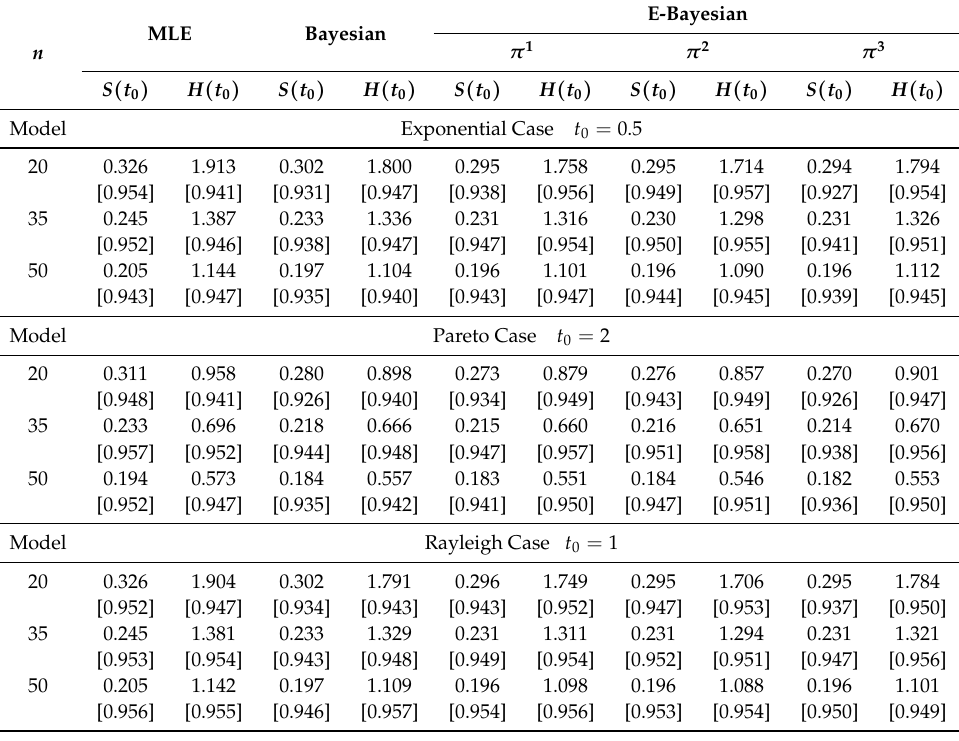
Table 4. The ALs and CPs (within bracket) of interval estimates with ( c 1 , c 2 , c 3 ) = ( 1.5,2,1.2 )